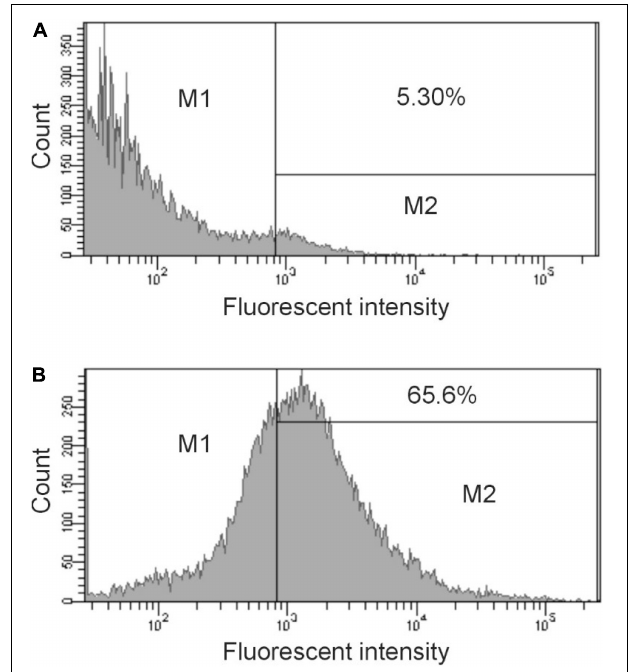
FIGURE 2 | Flow cytometry analysis of antibody binding to S. enterica ser. Typhimurium. Cells were treated with preimmunization sera (dilution 1:500) (A) or immunized sera (dilution 1:500) obtained after 28 days (B) followed by treatment with Cy3 goat anti-rabbit IgG (Life Technologies). The bacteria were analyzed by using FACS Calibur flow cytometer. Data were analyzed with CellQuest. Representative histograms from at least three independent experiments are shown. The bar in the figure represents the gate used to measure binding efficiency. The number in each figure corresponds to the percentage of the population that bound